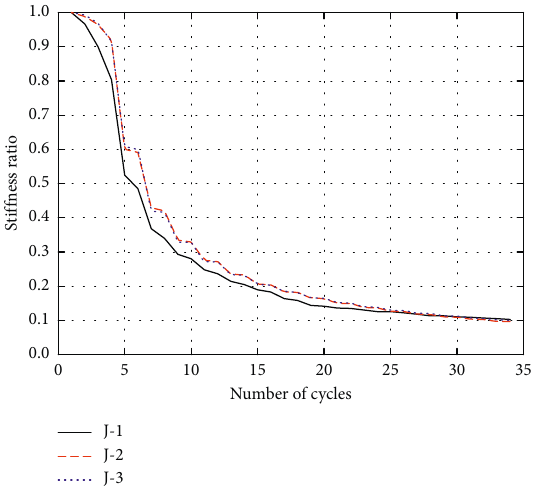
Figure 16: Comparison of stiffness degeneration.